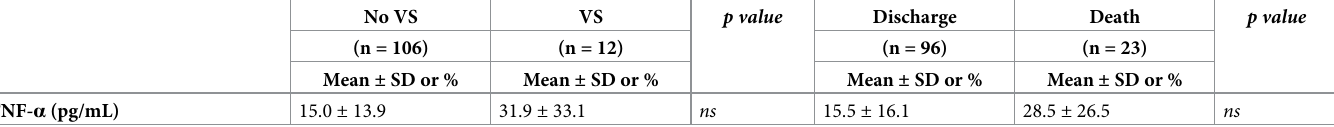
Table 3. Age- and gender-adjusted odds ratios of associations between comorbidities and ventilation support or in-hospital mortality. VS (NIMV +/- IMV)